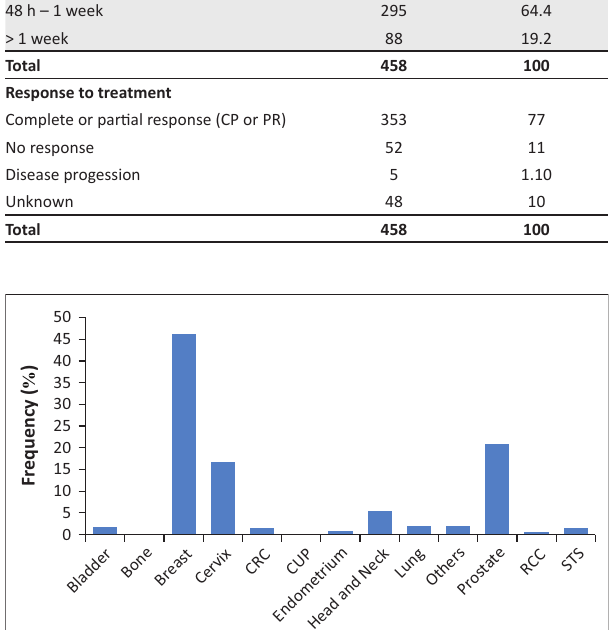
(Table 1). The majority (80 % ) of the earliest presentations